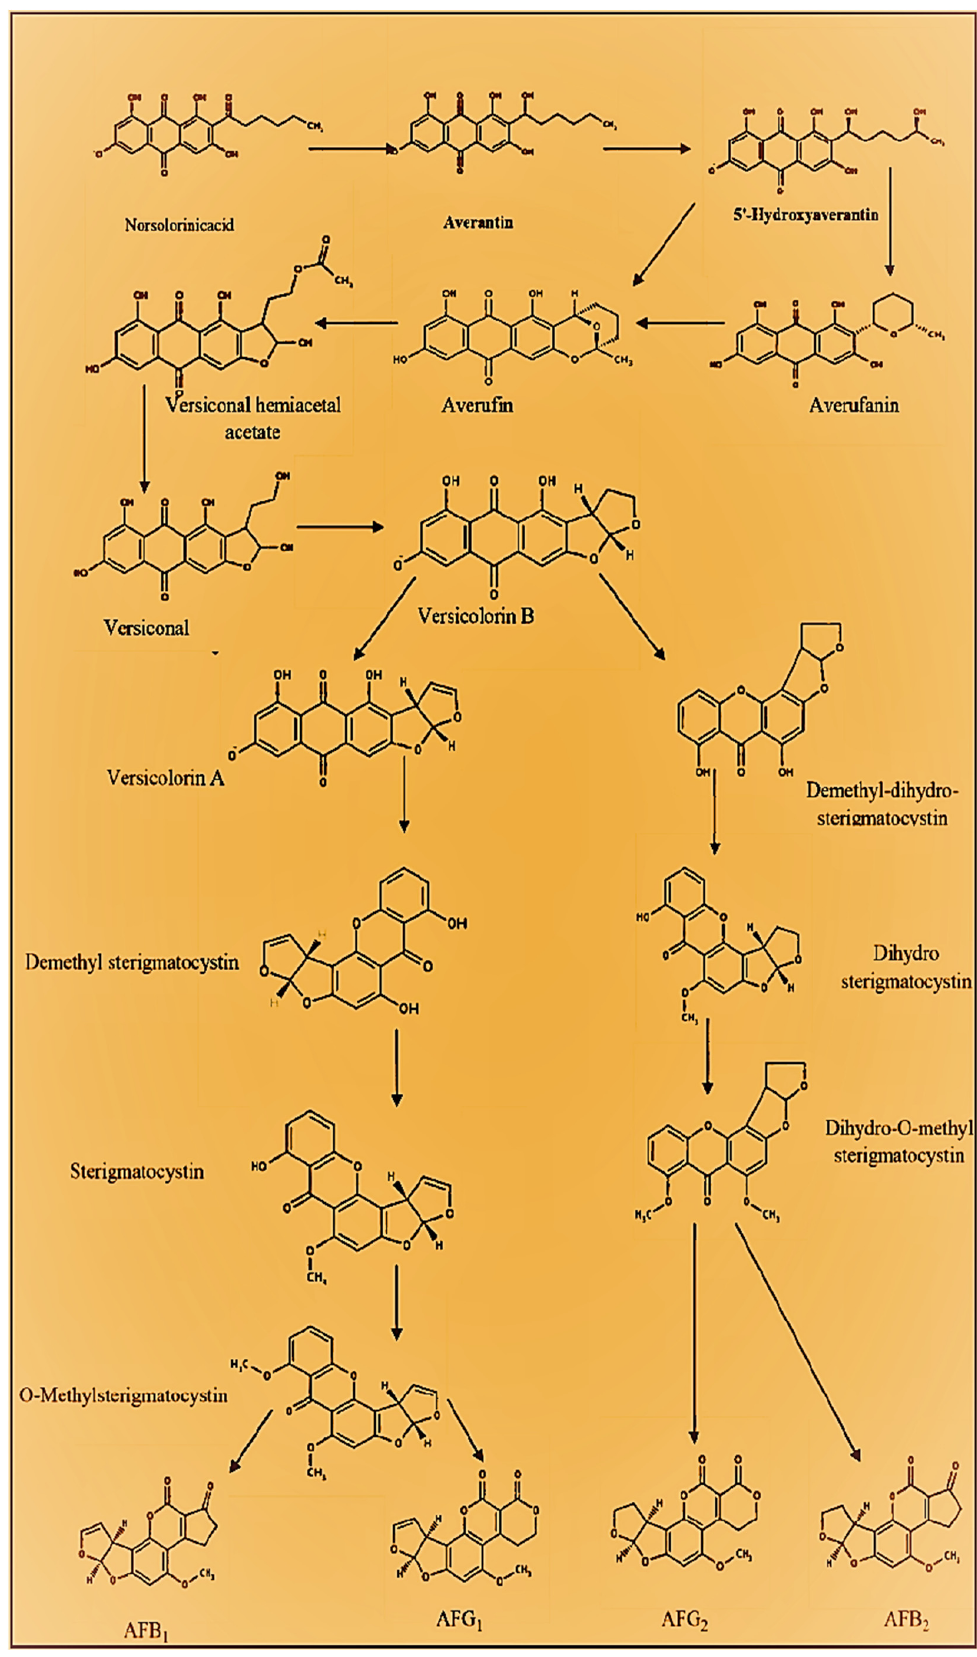
Figure 2. Biosynthetic pathway of AFs [22,23].